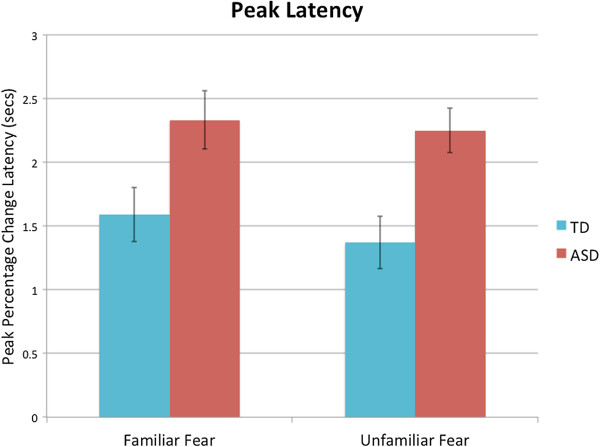
Peak pupillary change latency, in seconds, during the fear expression. Unadjusted means for each group and familiarity condition is shown. Error bars represent standard error.